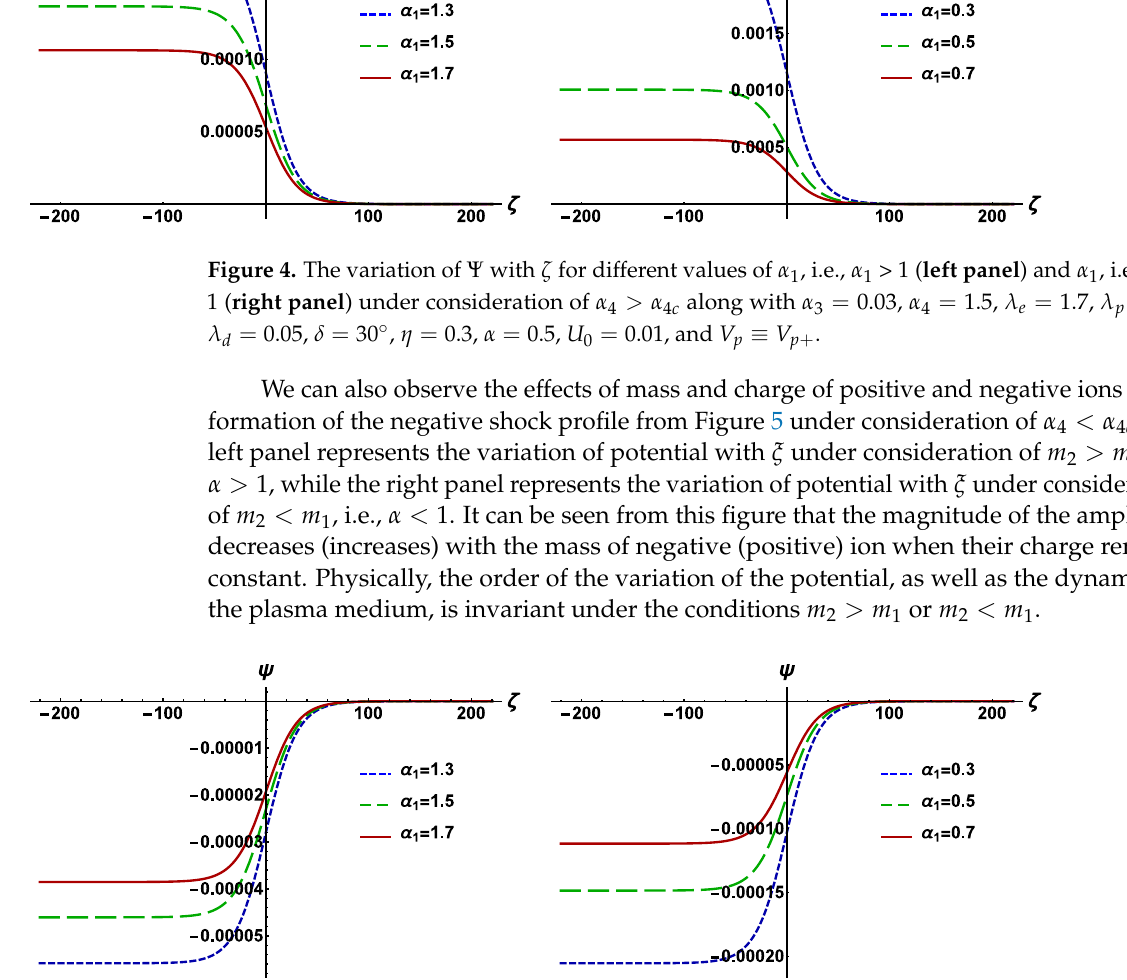
Figure 5. The variation of Ψ with ζ for different values of α 1 , i.e., α 1 > 1 ( left panel ) and α 1 , i.e., α 1 < 1 ( right panel ) under consideration of α 4 < α 4 c along with α 3 = 0.03, α 4 = 1.5, λ e = 1.7, λ p = 1.5, λ d = 0.05, δ = 30 ◦ , η = 0.3, α = 0.5, U 0 = 0.01, and V p ≡ V p +